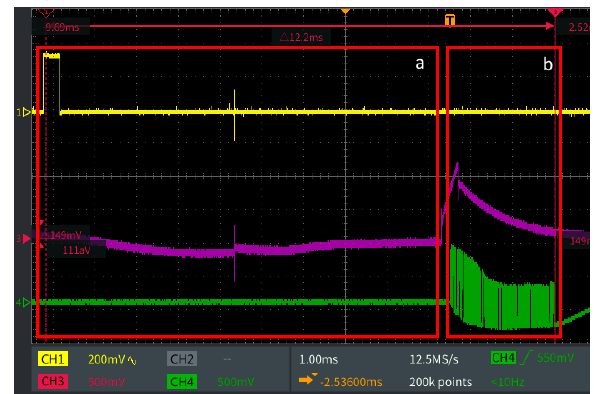
Figure 5. Maximum measured end-to-end latency.